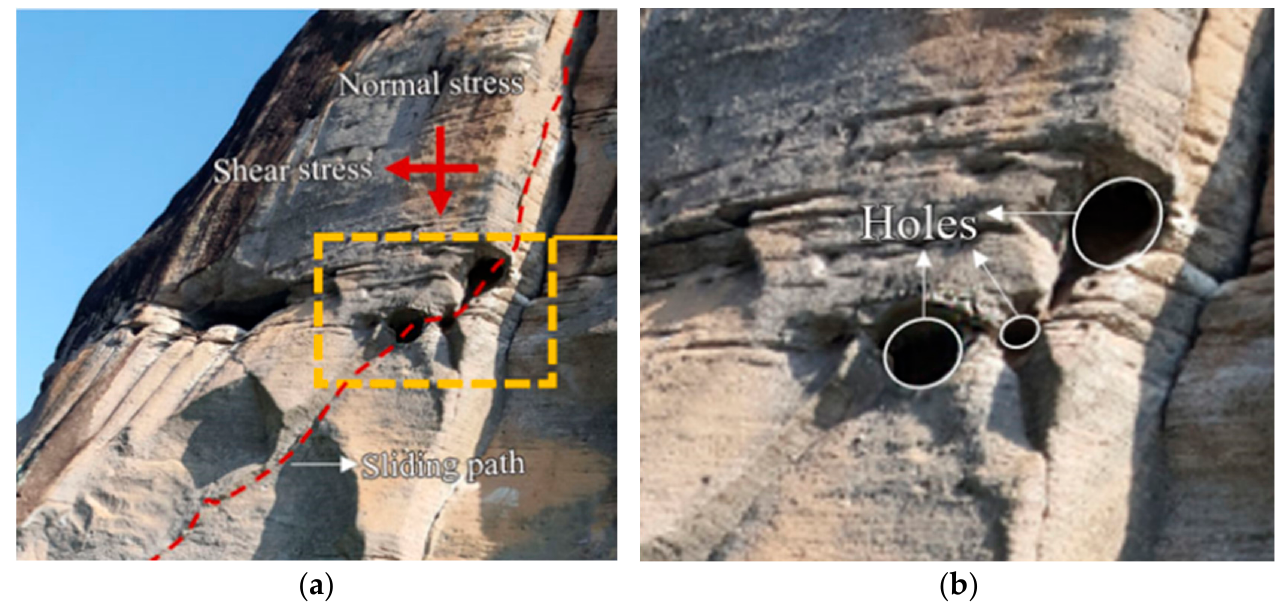
Figure 1. Shear failure of rock masses on high slopes: ( a ) shear path of rock masses with holes ( b ) description of the hole location.